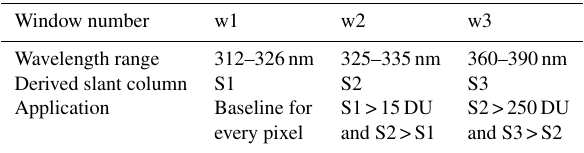
Table 3. Criteria for selecting alternative fitting windows. Window number